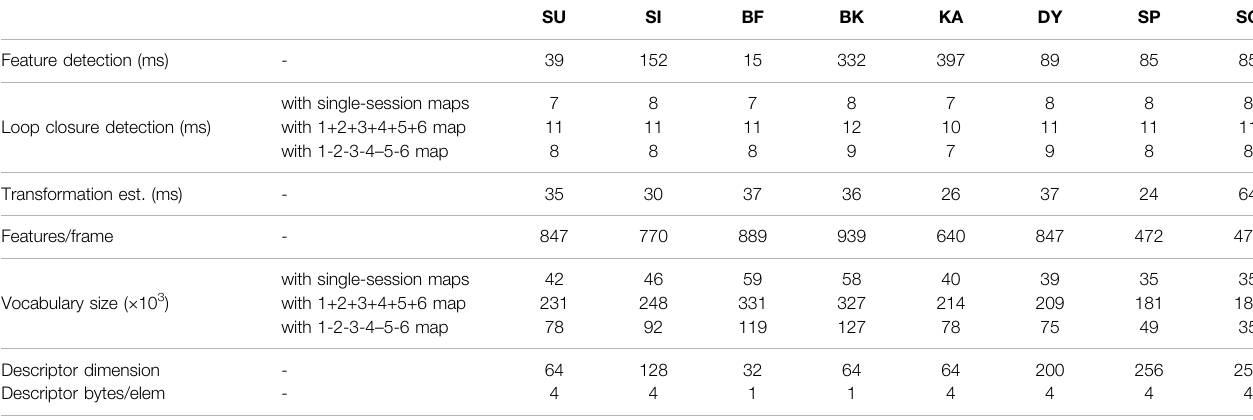
TABLE 5 | Average re-localization time and features per frame for each visual feature used, along with descriptor dimension and number of bytes per element in the descriptor.